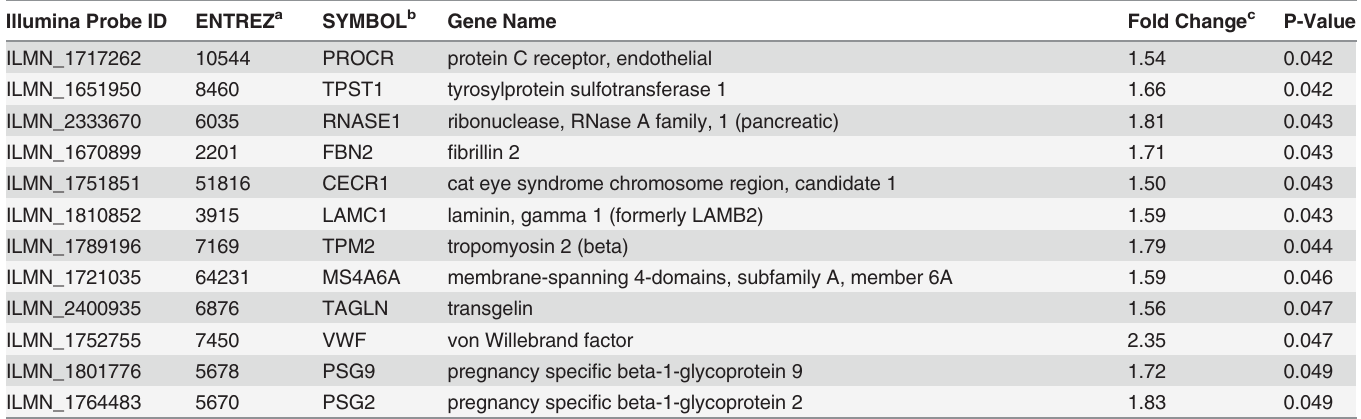
the average expression level in the normal comparison